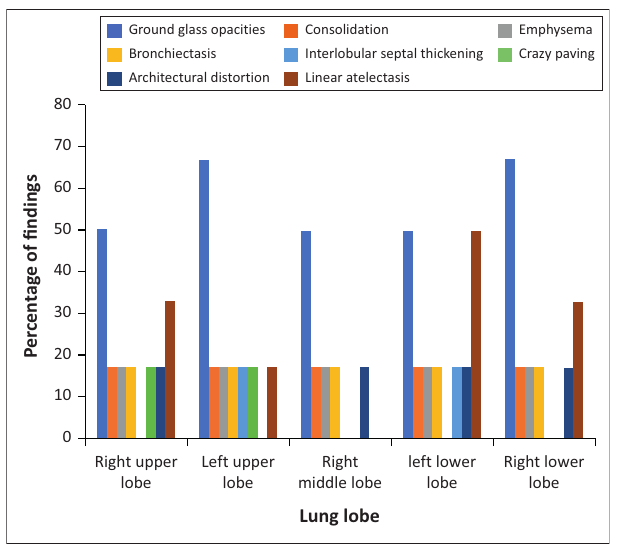
CT, computed tomography. FIGURE 5: Proportions of the lobar distribution and description of pathological findings on the chest CTs. Ground glass opacities and consolidation were the most common findings.